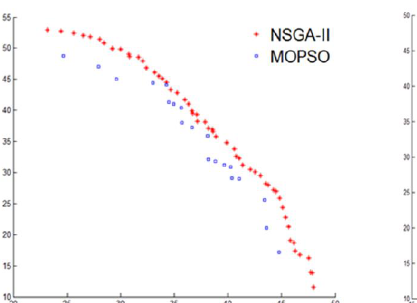
Fig. 12. Extracted non-dominated solutions by different approaches for permutation problem with 13 alternatives